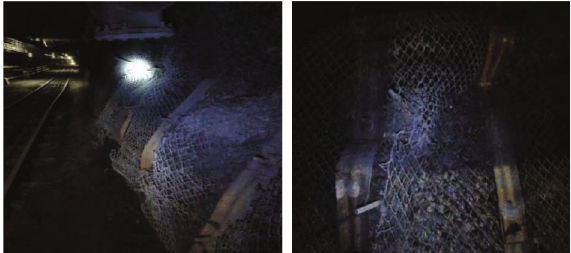
Figure 4: Deformation and failure characteristics of roadway surrounding rock.